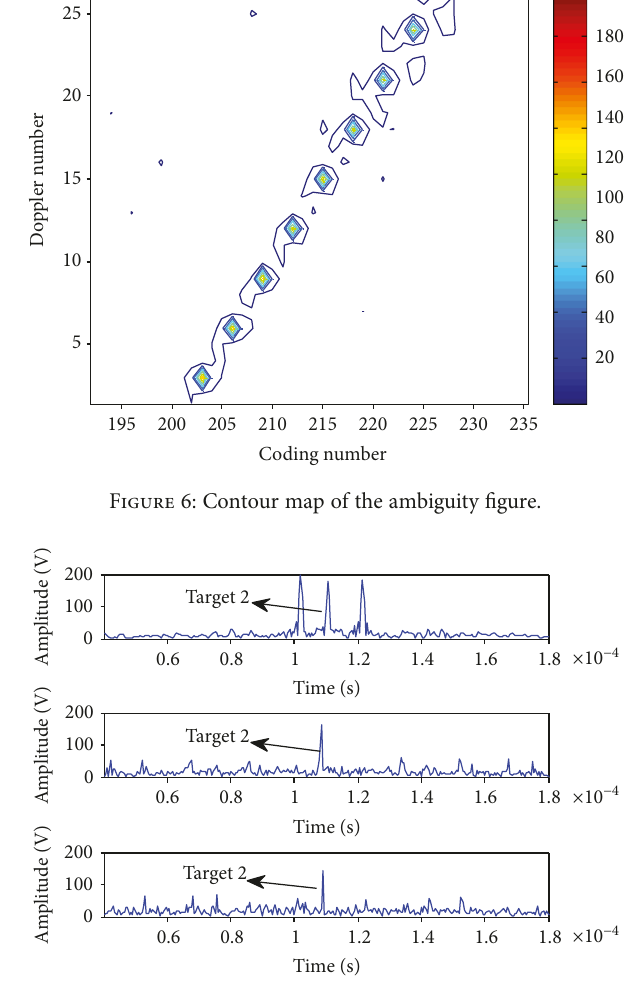
Figure 7: Results of transmitting the LFM signal, signal I ( K = 3 , q = 2 ) and signal II ( K = 3 , q = 3 ) after the pulse compression. 1 2